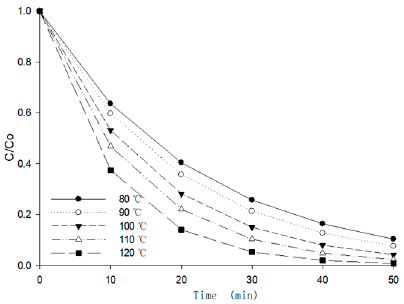
Figure 11. The effects of temperature on the anthocyanin retention ratio of berry puree. Table 6. The degradation rate constants, activation energy and reaction heat of anthocyanins in berry puree at different temperatures.